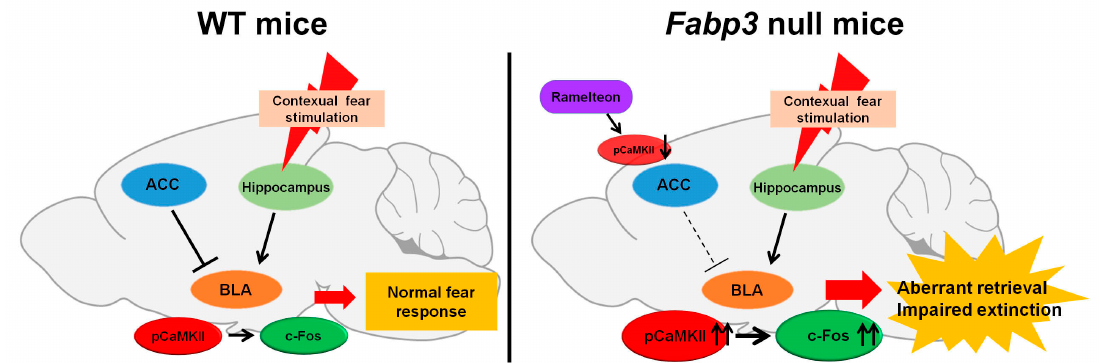
Figure 4. The hypothesis of neuronal circuits in the fear extinction in WT and Fabp3 null mice. (Left) Contextual fear memory is acquired in the hippocampus and then consolidated and retrieved in the BLA. The ACC negatively regulates neuronal activity in BLA, resulting in suppression of exacerbated fear retrieval and facilitation of fear extinction in WT mice. (Right) Hypofunction in the ACC fails to inhibit aberrant neuronal activity in the BLA, leading to the development of aberrant fear retrieval and impaired fear extinction in Fabp3 null mice. Ramelteon improves decreased neuronal activity in the ACC through stimulation of the melatonin receptors. Therefore, ramelteon improves the impaired fear extinction by suppressing hyperactivation of BLA in Fabp3 null mice (Right). Modified data derived from Reference [170].